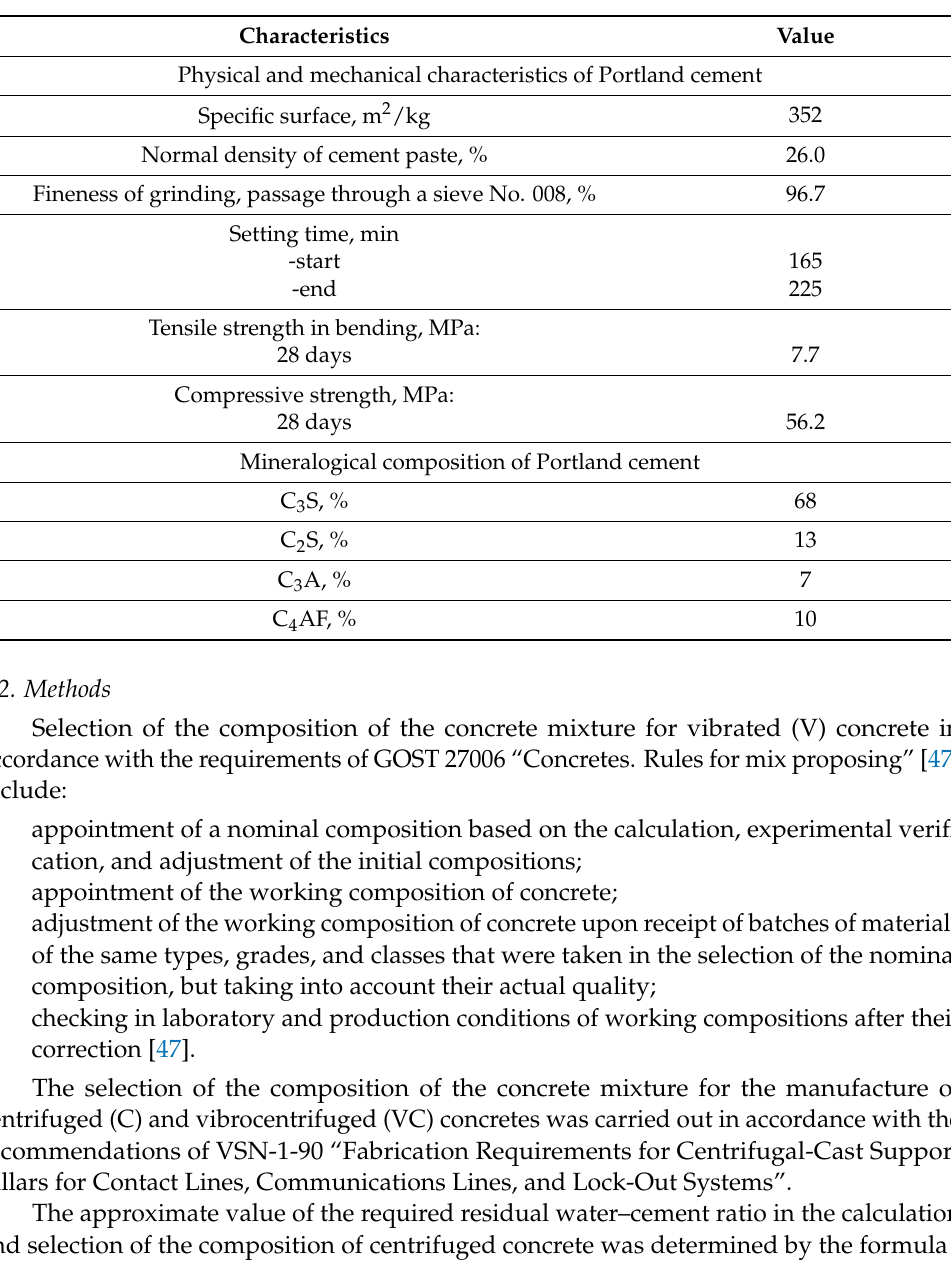
Table 8. Characteristics of Portland